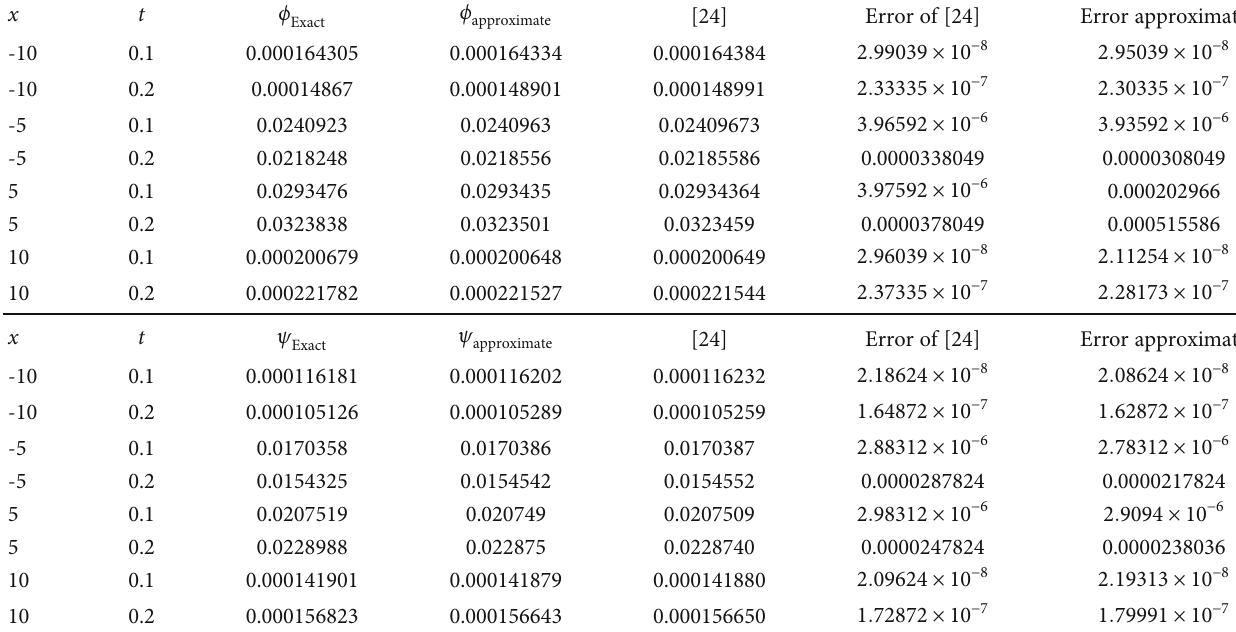
Table 1: Numerical outcomes of the exact and approximate solutions and the results obtained in [27]. x t ϕ